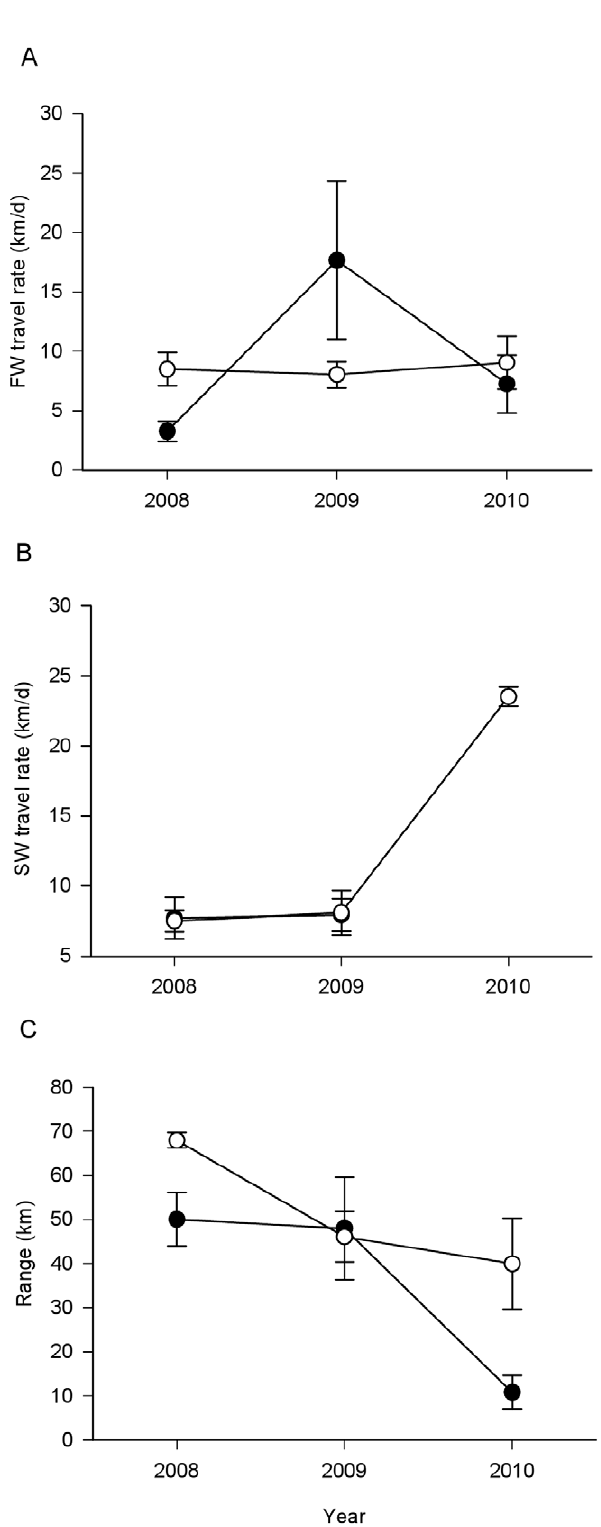
Figure 4. Migration behavior of wild and hatchery Skokomish smolts. (A) Mean travel rate ( 6 SE) from the point of release to the river mouth (13.5 km) for hatchery (black circles) and wild (open circles) individuals from the Skokomish River. (B) Mean travel rate ( 6 SE) from the river mouth to the Hood Canal Bridge (75 km) for hatchery (black circles) and wild (open circles) individuals from the Skokomish River. (C) Mean migration range (distance between the Skokomish River estuary